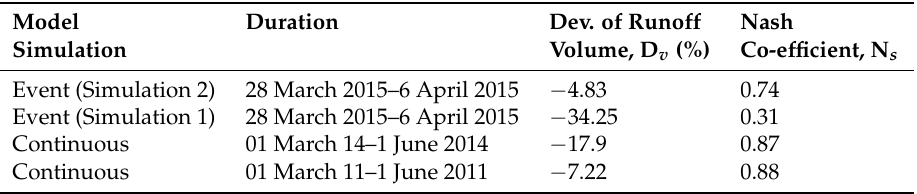
Table 3. Performance measures of the HEC-HMS